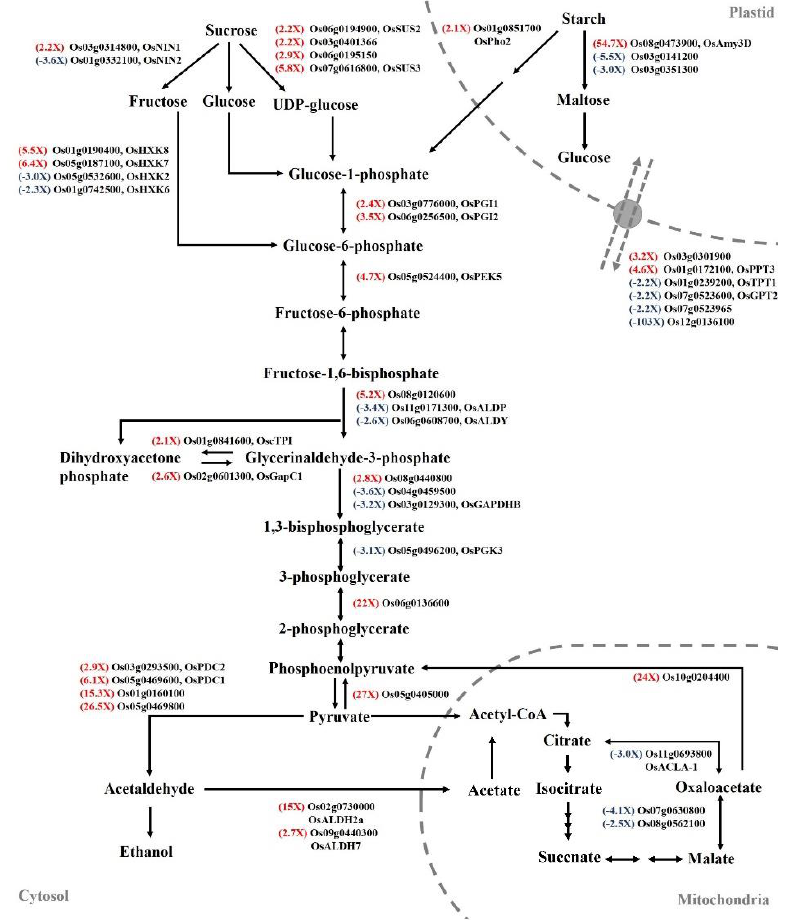
Figure 5. Differentially expressed genes involved in starch degradation, glycolysis, and fermentation pathways. Red text represents fold change (FC) and significant upregulation in SUB + TIBA treatment compared with SUB treatment. Blue text represents FC and significant downregulation. The qRT-PCR profile confirmed that the transcript levels of carbohydrate-metabolism–related genetic expression were similar to the RNA-Seq results. The transcript levels of amylase ( Os08g0473900 ), sucrose synthase ( Os07g0616800 ), hexokinase ( Os05g0187100 and Os01g0190400 ), fructose-bisphosphate aldolase ( Os08g0120600 ), phosphoenolpyruvate carboxykinase ( Os10g0204400 ), lactic acid dehydrogenase ( Os02g0730000 ), pyruvate decarboxylase ( Os05g0469600 ), and phosphoenolpyruvate/phosphate translocator ( Os01g0172100 ) were induced, and plastidic phosphate translocator ( Os12g0136100 ), fructose-bisphosphate aldolase ( Os11g0171300 ), and glyceraldehyde-3-phosphate dehydrogenase ( Os03g0129300 ) were reduced under SUB + TIBA treatment (Figure 6). Our results indicate that auxin signaling is involved in energy production processes under submerged conditions. The red word showed upregulated genes, whereas the blue word showed downregulated genes.